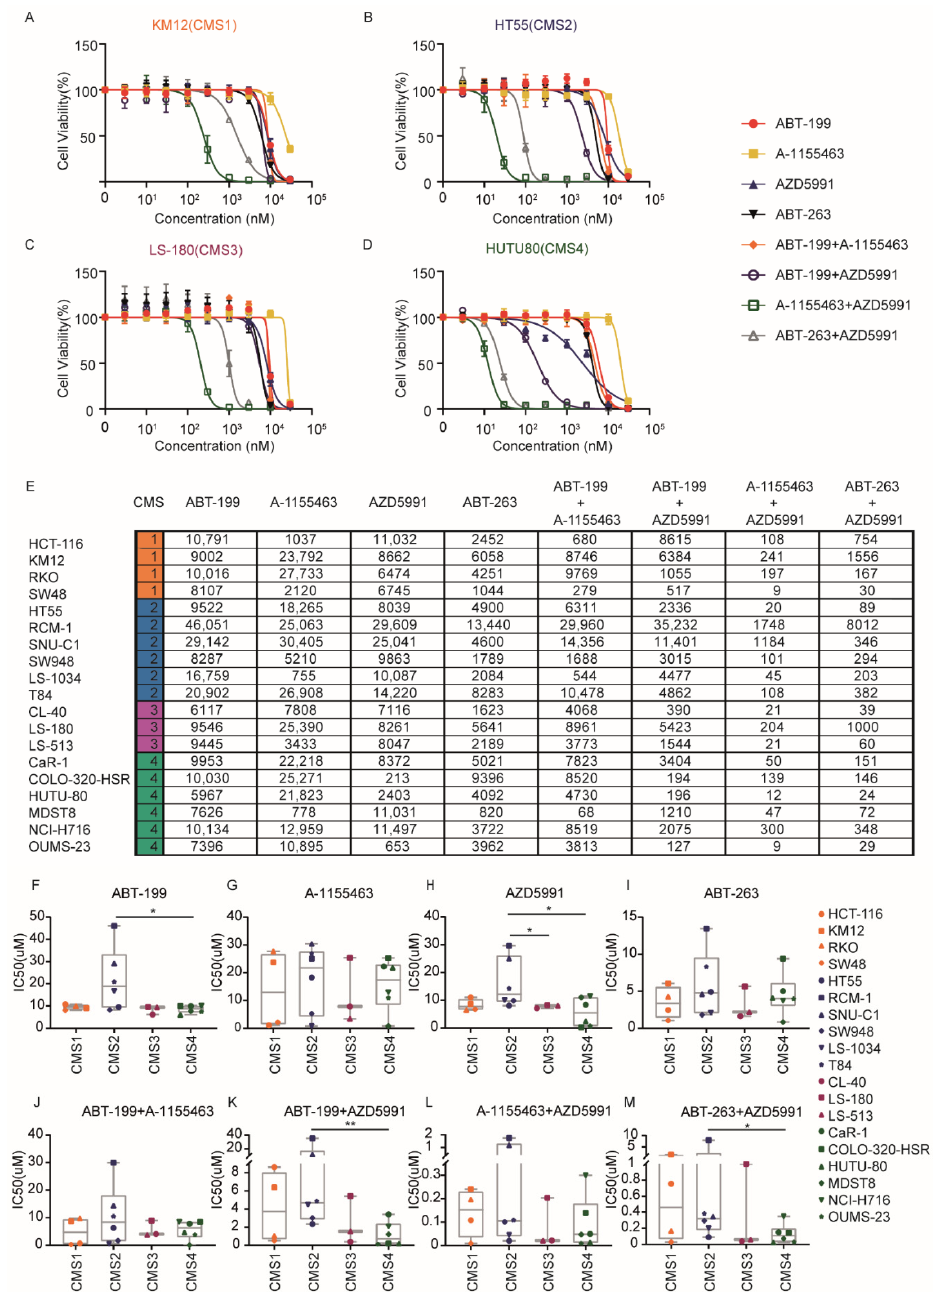
Figure 1. Differential sensitivity to BH3 mimetics in colorectal cancer (CRC) cells. ( A – D ) Dose-response curves of four BH3 mimetics and four combinations (1:1) in four representative CRC cell lines of each subtype. The Y-axis indicates the relative cell viability normalized to the untreated control. The legend for ( A – D ) indicates the symbol for the different mimetic treatments used. ( E ) IC50 values for BH3 mimetics and combinations tested on all 19 CRC cell lines, in nM; ( F – I ) IC50 values of four single BH3 mimetics in the CRC cell line panel grouped according to their CMS. *: p < 0,05; ( J – M ) IC50 values of four combinations (1:1) in the CRC cell line panel grouped according to their CMS. **: p < 0.01; *: p < 0,05, Mann- Whitney test (one-tailed). The legend indicates the symbols assigned for each cell line.